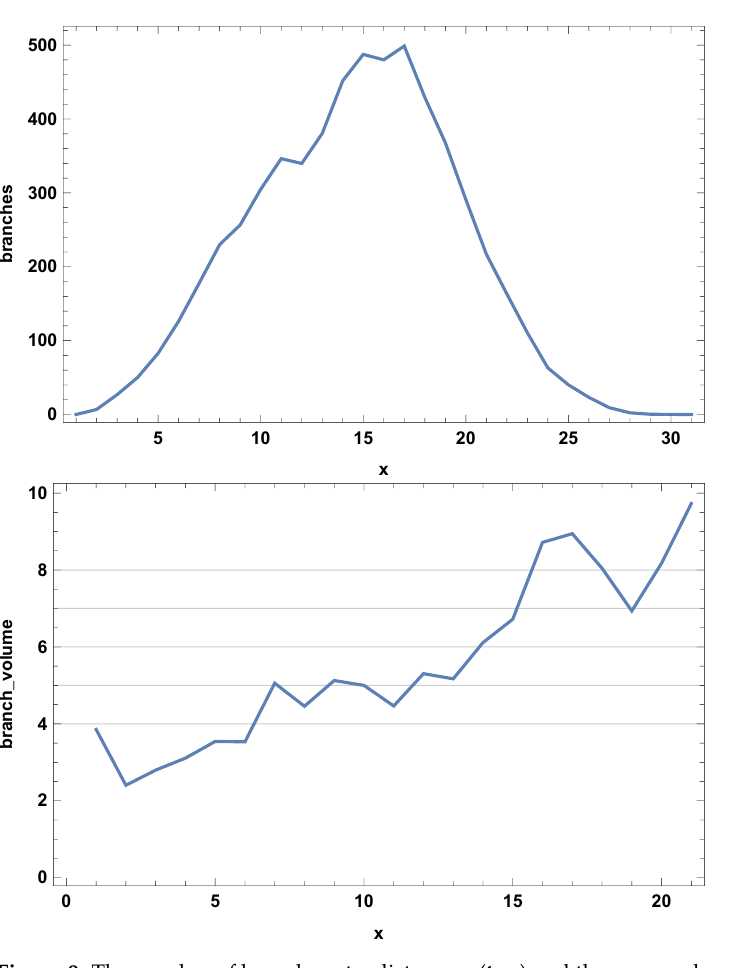
Figure 9. The number of branches at a distance x ( top ) and the average branch volume ( bottom ) in a triangulation from phase C dS .